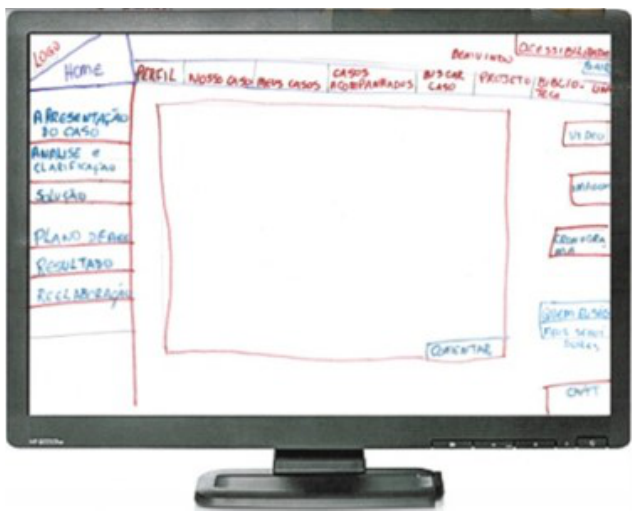
Fig. 11. Brain Draw example, extracted from